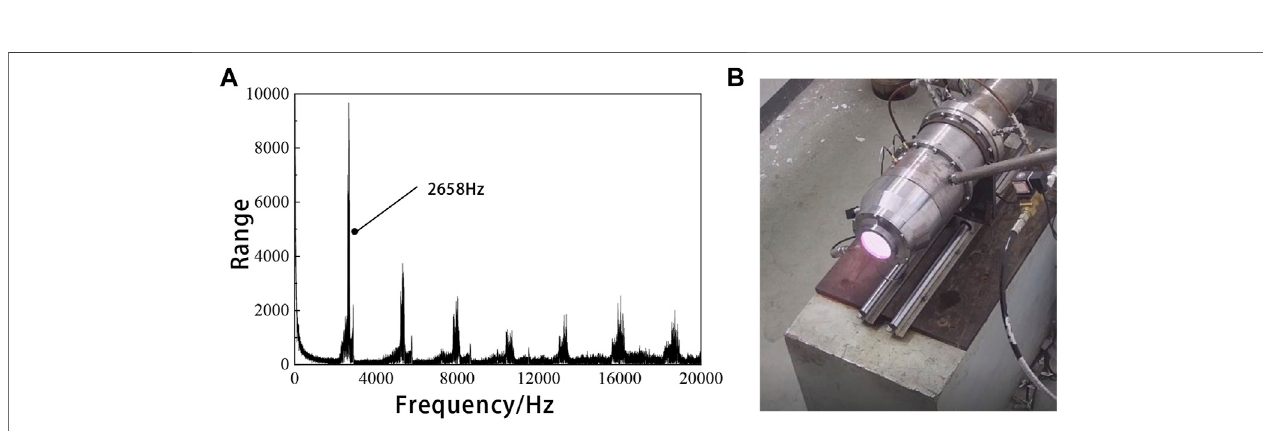
FIGURE 14 | Results of operating at T 0 (cid:1) 650K, _ m air (cid:1) 1 . 5kg/s, φ (cid:1) 0 . 987. (A) The FFT frequency distribution by P 1 ; (B) The Photograph of RDE.